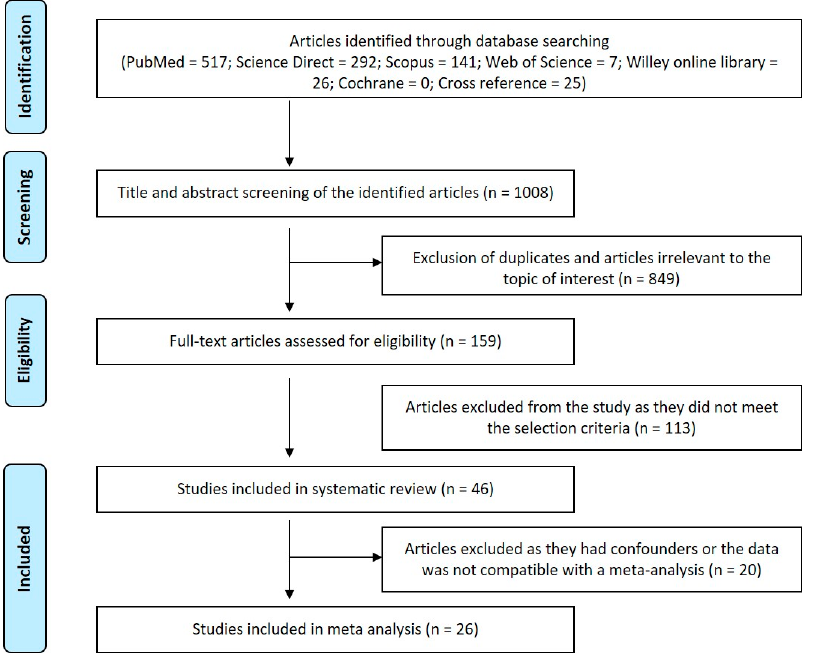
Figure 1. Prisma Flow Chart—Study Selection.